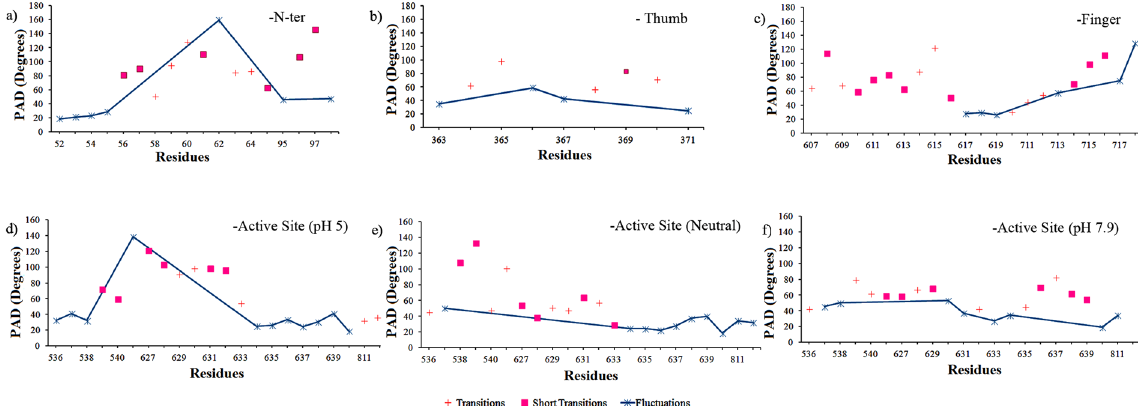
Figure 5. The residue fluctuations, transitions and short transitions of selected regions of T7RNAP calculated using T-pad tool and plotted based on the residue and their PAD degree from 100 ns MD simulation. The local fluctuations identified from the regions with high RMSF at pH 5 were shown for ( a ) N-terminal and ( b ) Thumb sub-domain and ( c ) finger sub-domain. The plots: ( d , e and f ) shows local fluctuations in the residues in vicinity of active site region at, pH 5, neutral pH and pH 7.9